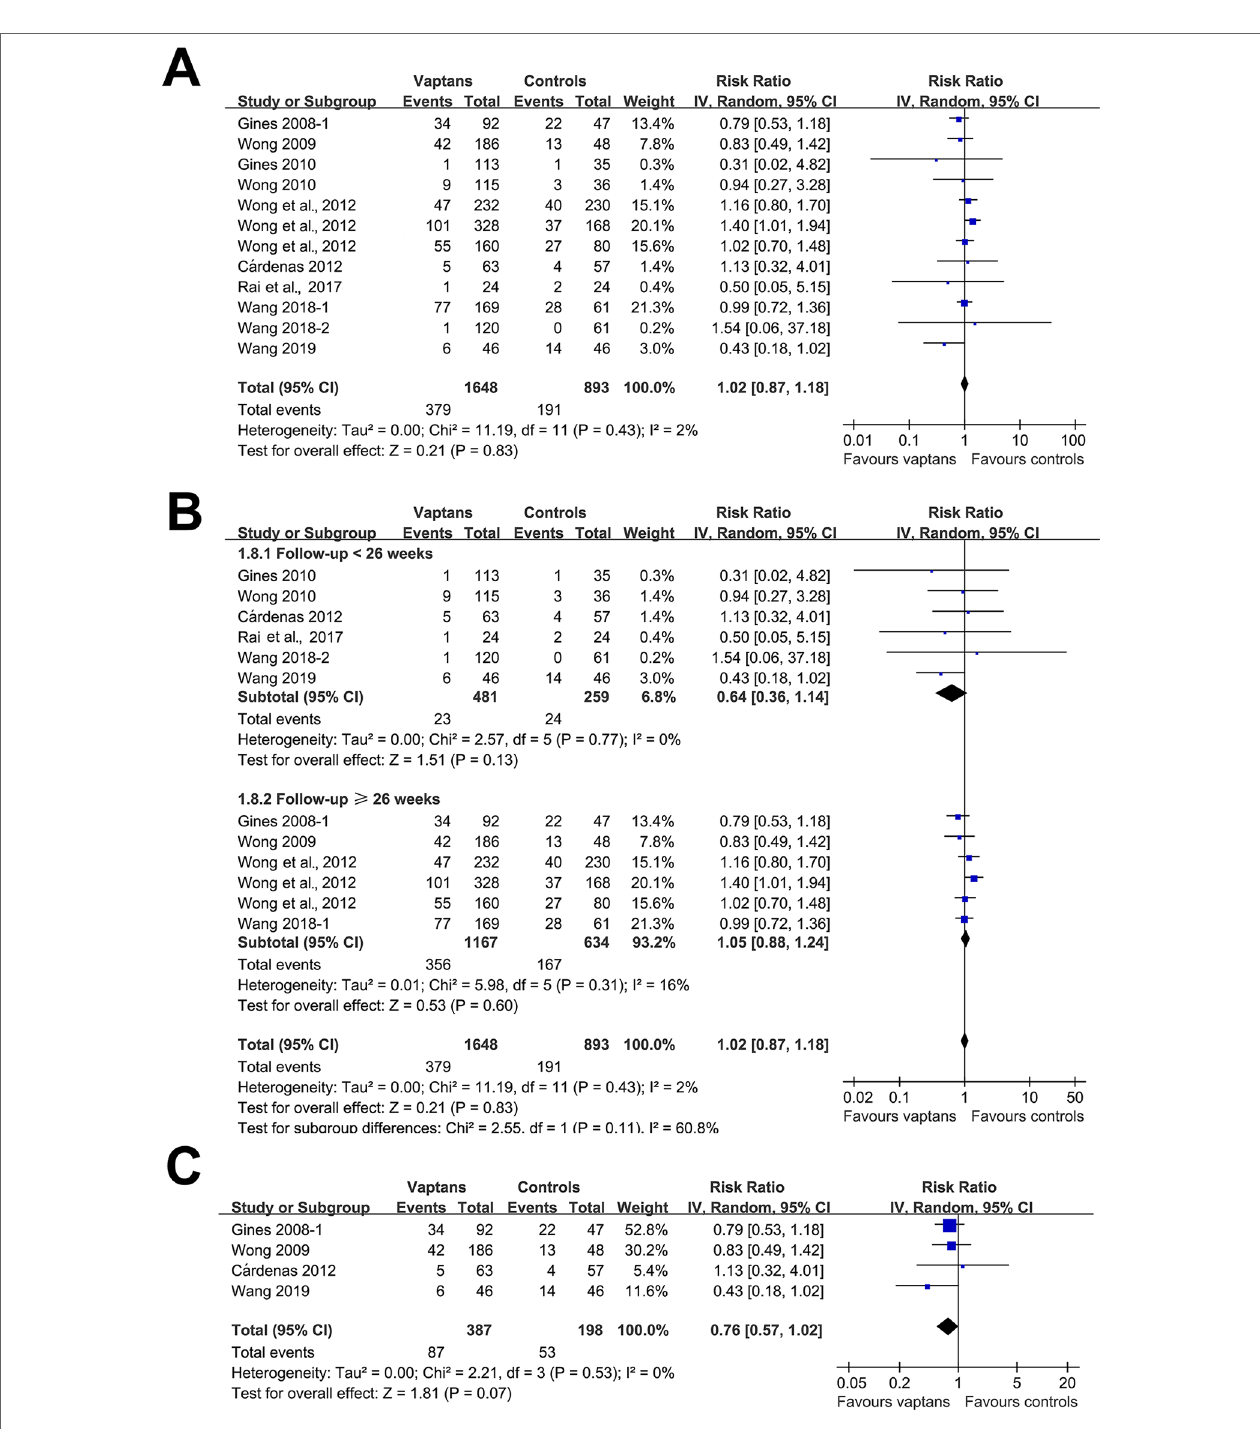
FIGURe 2 | Forest plots for meta-analysis of the influence of vaptans on all-cause mortality in cirrhosis patients. (A) Overall meta-analysis. (B) Subgroup analysis according to the follow-up duration. (C) Sensitivity analyses limited to studies involving cirrhosis patients with hyponatremia before treatment.